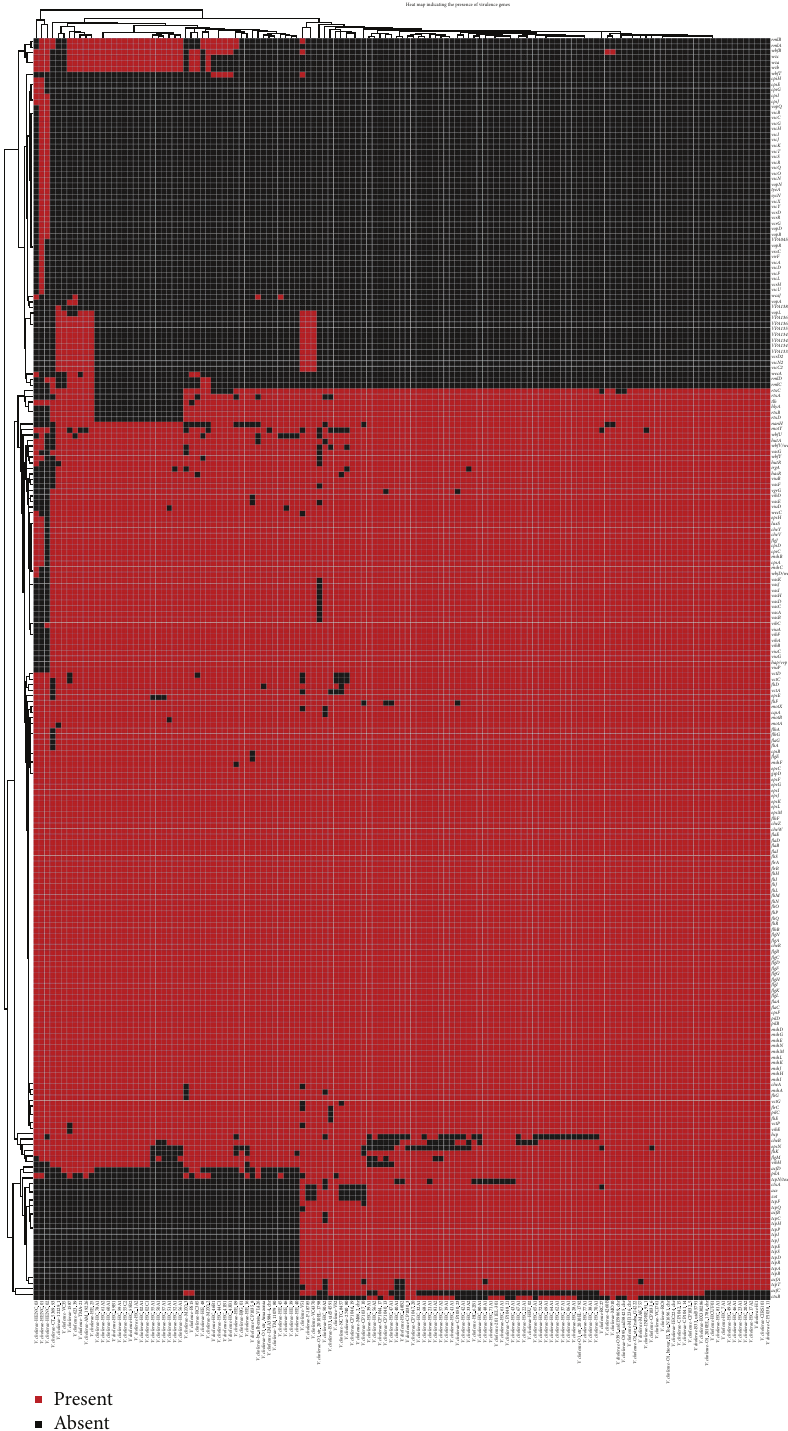
Figure 3: The profiling of virulence genes of 134 V. cholerae strains using PathoProT. The heat map was generated by using the thresholds of 50% completeness and 50% identity. It gave an overview ofthe clustered strains having closely related sets of virulence genes, sorted according to the level of similarities across the strains and genes. The flagella formation gene clusters ( flgB-flgC-flgD-flgF-flgG-flgH-flgI-flgK-flgL ) are the largest conserved virulence gene group among the V. cholera strains. The flg gene cluster works with other virulence gene clusters such as fla gene cluster ( flaA-flaB-flaC-flaD-flaE ) [17] and fli gene cluster ( fliH-fliJ-fliL-fliM-fliN-flnO-fliP-fliQ-fliR-fliS ) to form the flagella organelles on the bacteria [18], which is one of the common characteristics among all cholerae